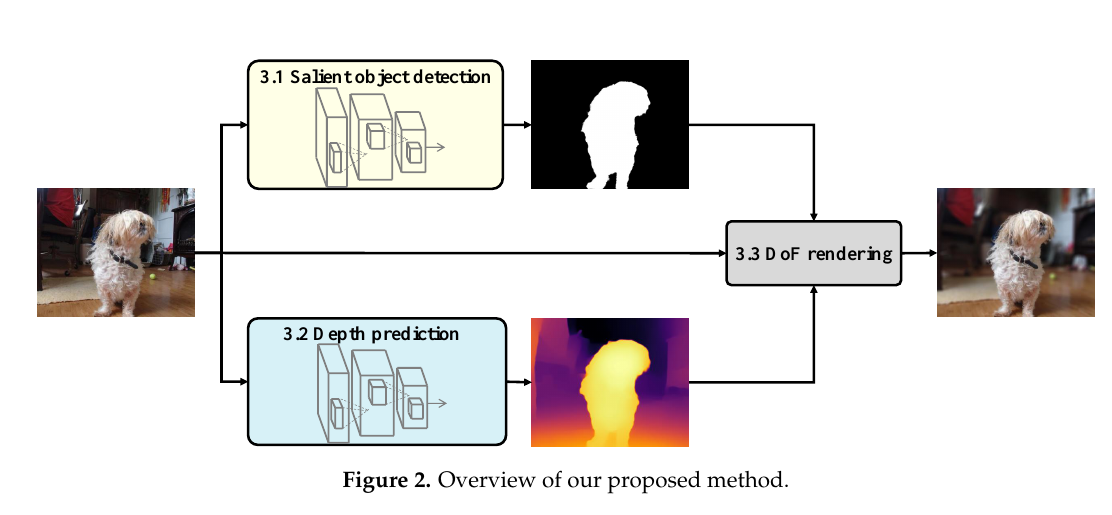
Figure 2. Overview of our proposed method.